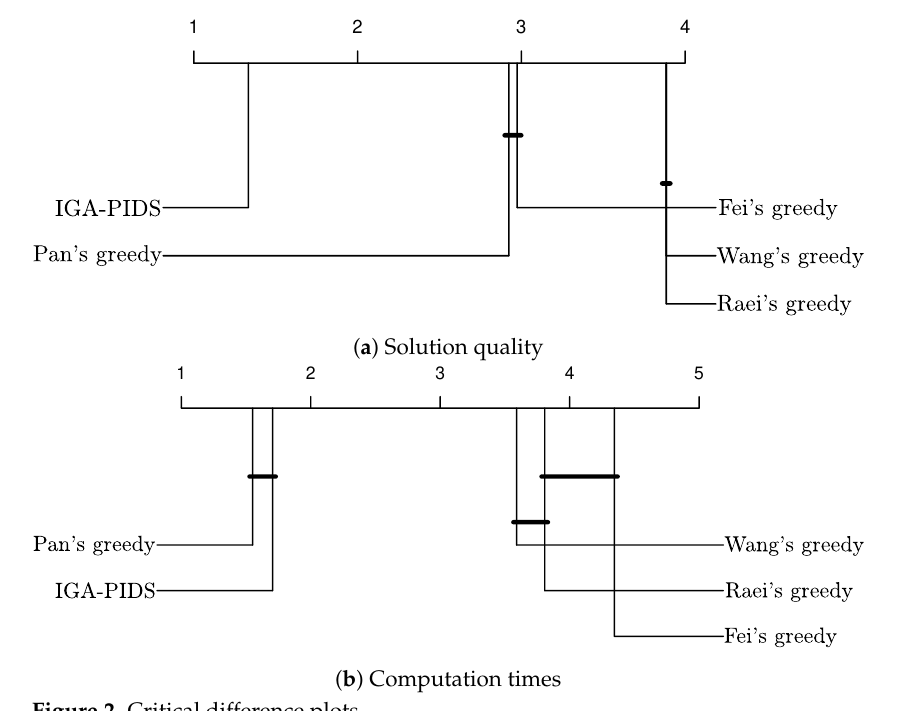
Figure 2. Critical difference